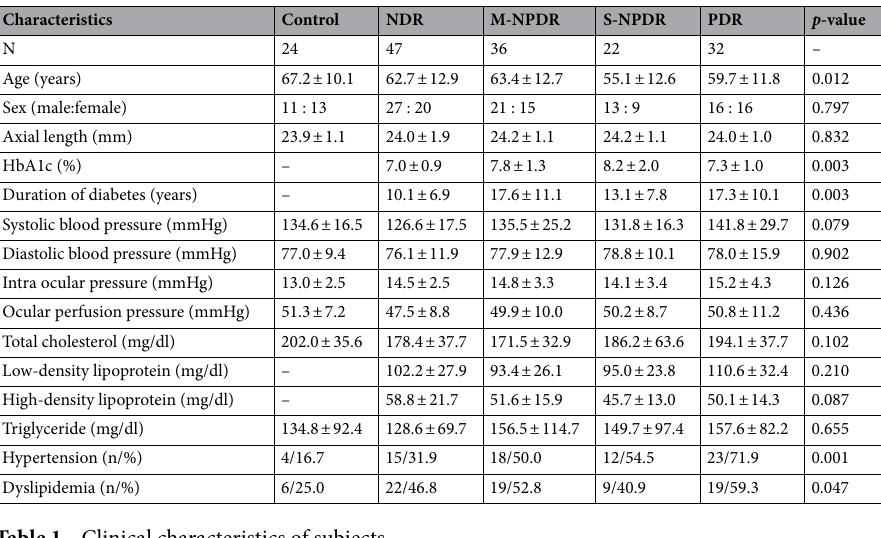
Table 1. Clinical characteristics of subjects.